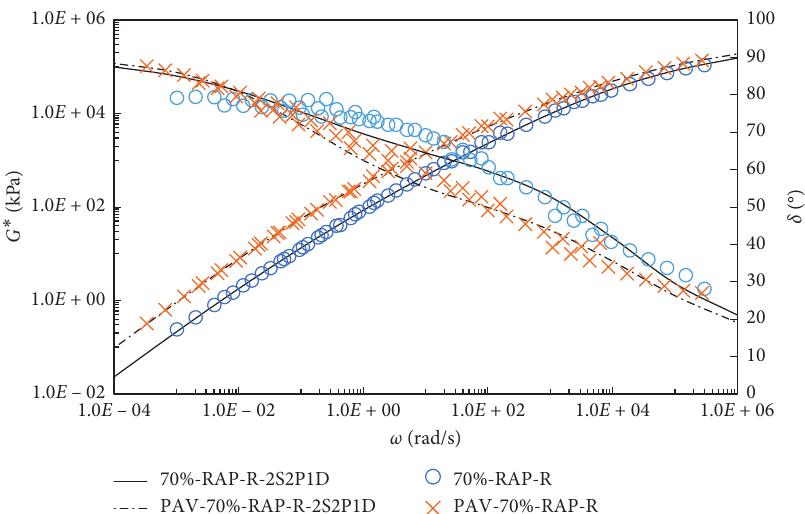
Figure 13: Complex shear modulus and phase angles master curves for RAP-R binder containing 70% RAP binder before and after PAV